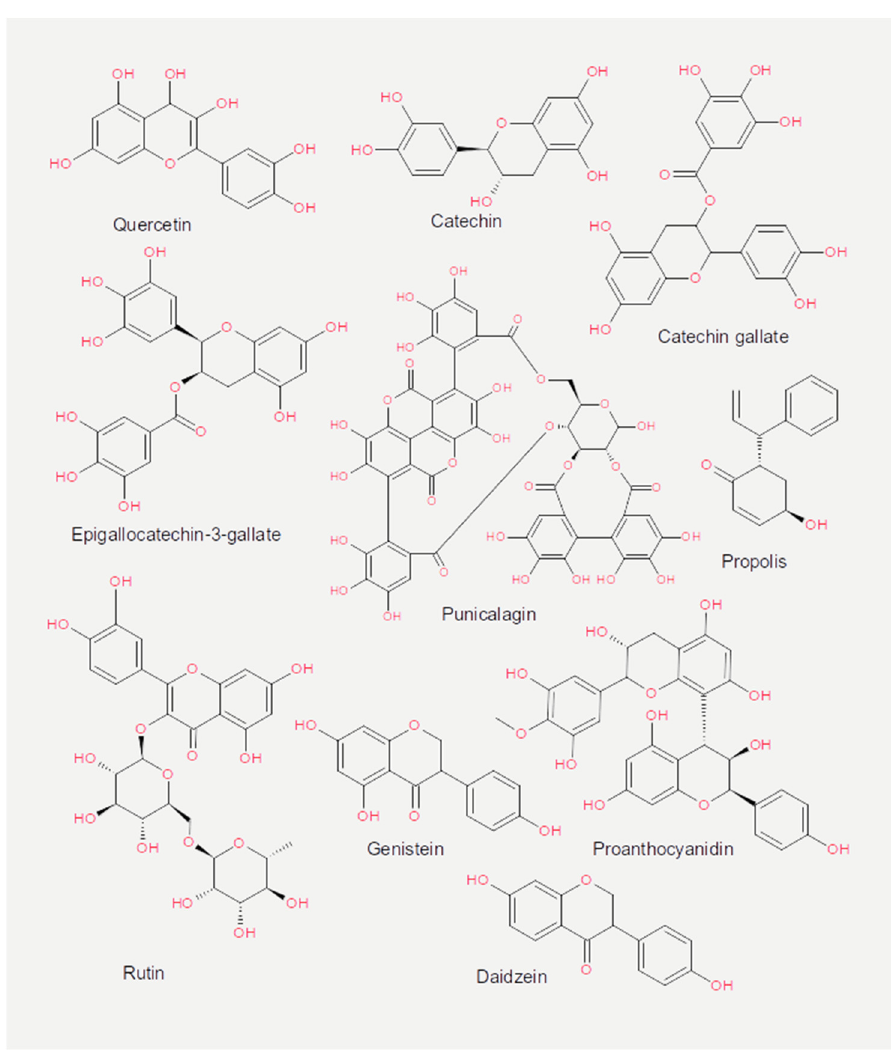
Figure 4. Chemical structures of the flavonoids reported in the present review.